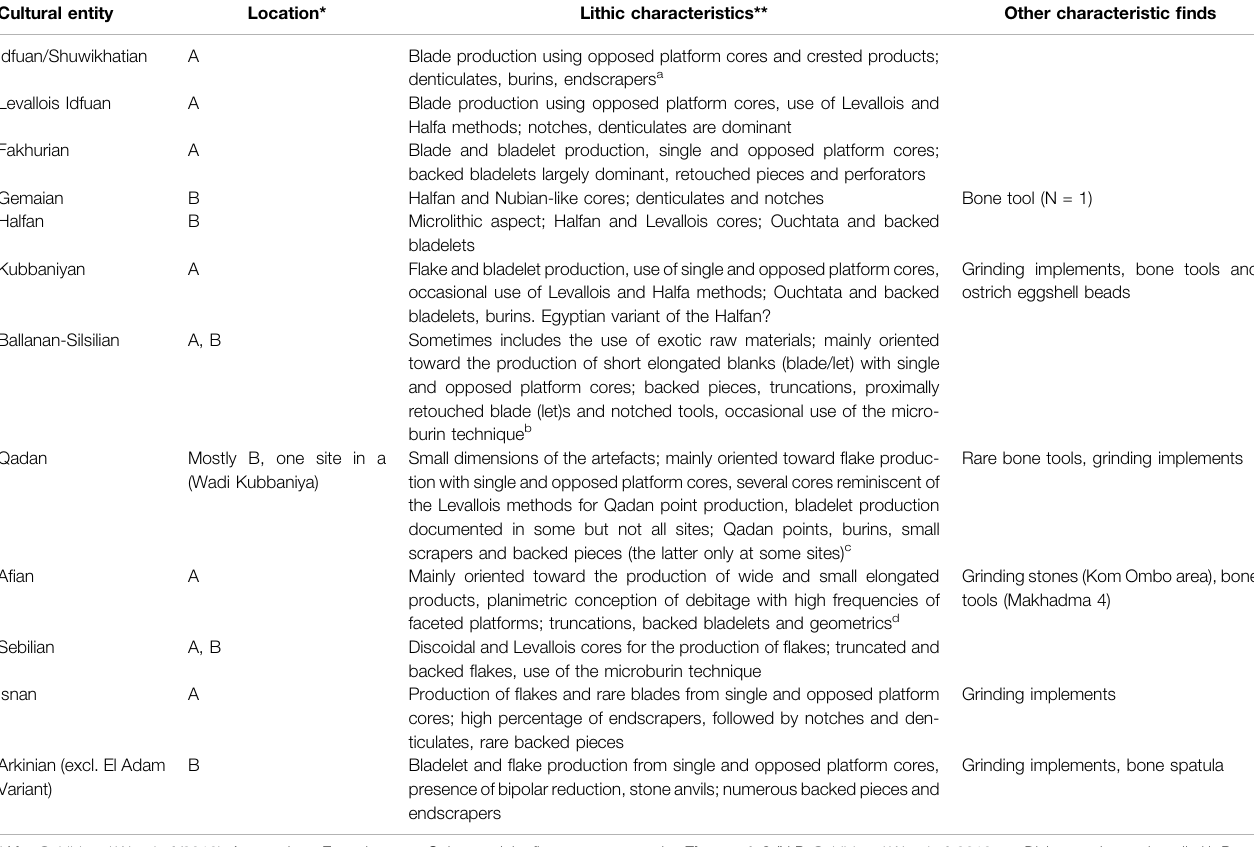
TABLE 2 | Characteristics of cultural entities of the Late Palaeolithic in the Lower Nile Valley. Cultural